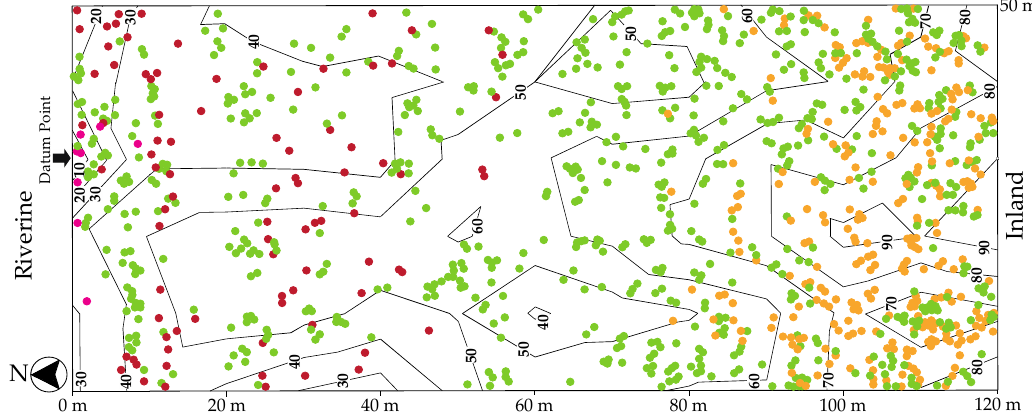
Figure 4. Relative elevation (cm) of the study plot shown by line contours reference to the datum point located on the river edge, and position of trees with DBH > 4.5 cm, including Sonneratia caseolaris and Avicennia alba (indicated with a red circle symbol), Rhizophora apiculata and R. mucronata (green circle symbol), and the other species (yellow circle symbol) in the permanent plot in 2017.